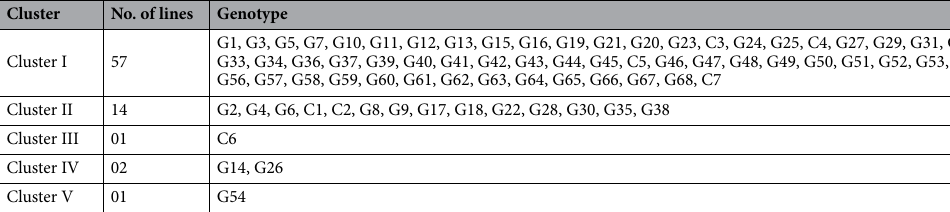
Table 4. Grouping of 75 advanced breeding lines into five different clusters based on twelve quantitatively contributing traits by D2 analysis.